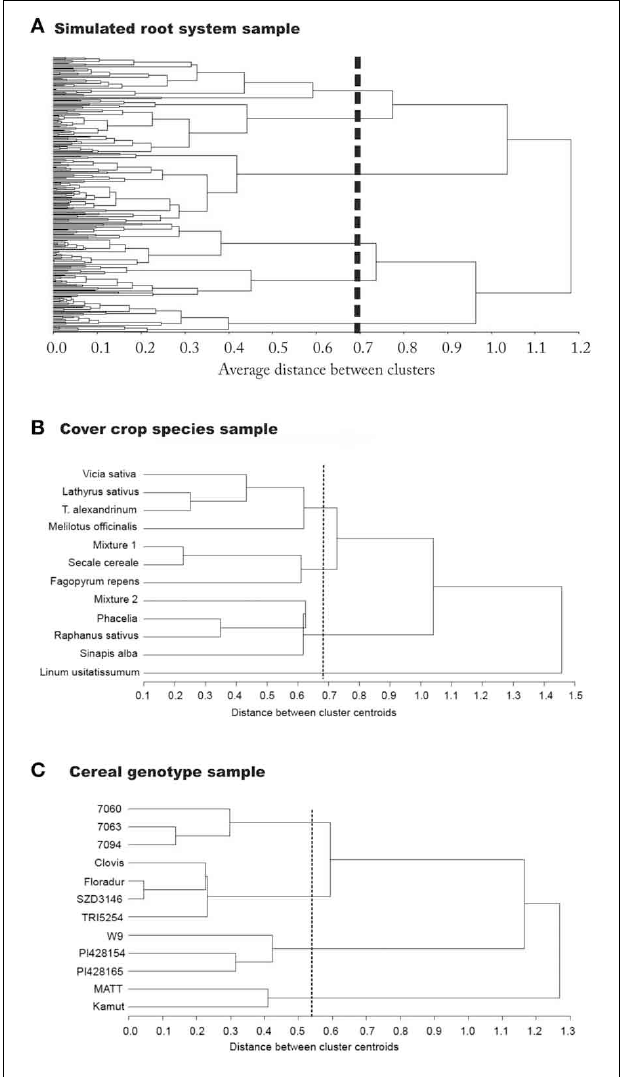
FIGURE 4 | Dendrograms showing the classification result from principal component based rooting types used as classifiers. Results are from (A) the simulation sample, (B) the cover crop species sample, and (C) the cereal genotype